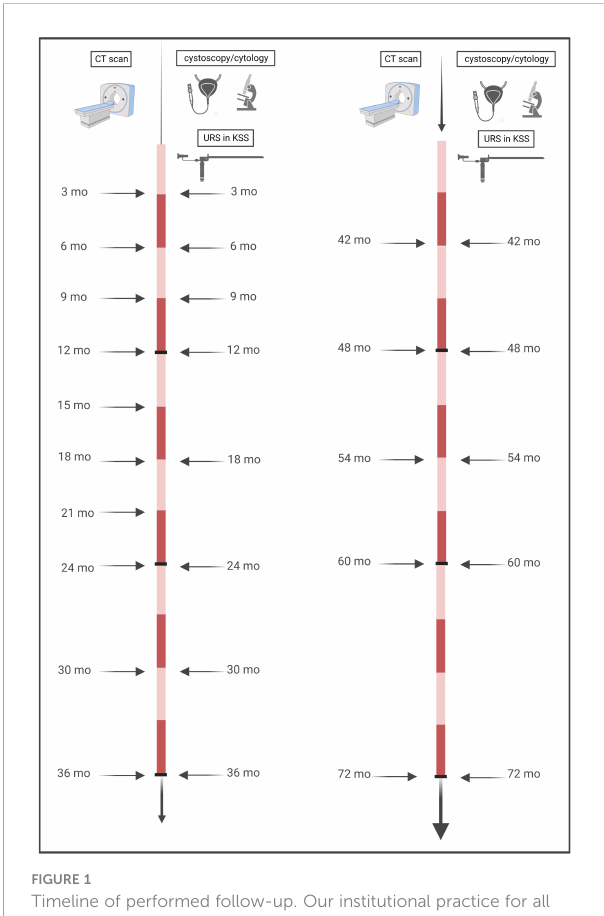
FIGURE 1 Timeline of performed follow-up. Our institutional practice for all (low-risk and high-risk) patients, irrespective of the method of surgery, consisted of close-meshed imaging intervals of three months for the fi rst two years, with six-monthly continuation thereafter until the fi fth year, and then yearly. Cystoscopies with ipsilateral URS for KSS were performed every three months in the fi rst year, followed by six-monthly intervals until the fi fth year, and then